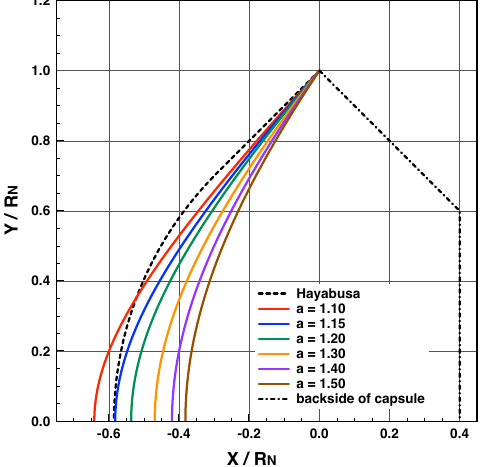
Figure 1. Shape of the capsule with hyperbolic contours.